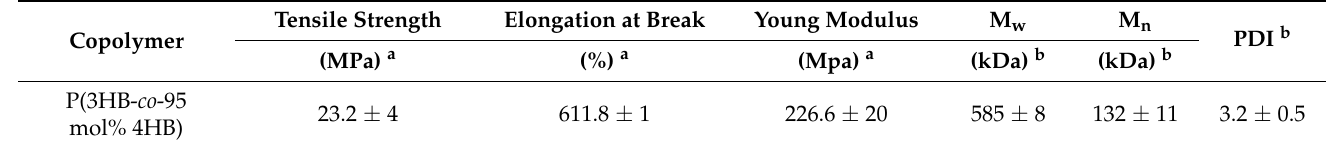
Table 2. Physical and mechanical properties of P(3HB- co